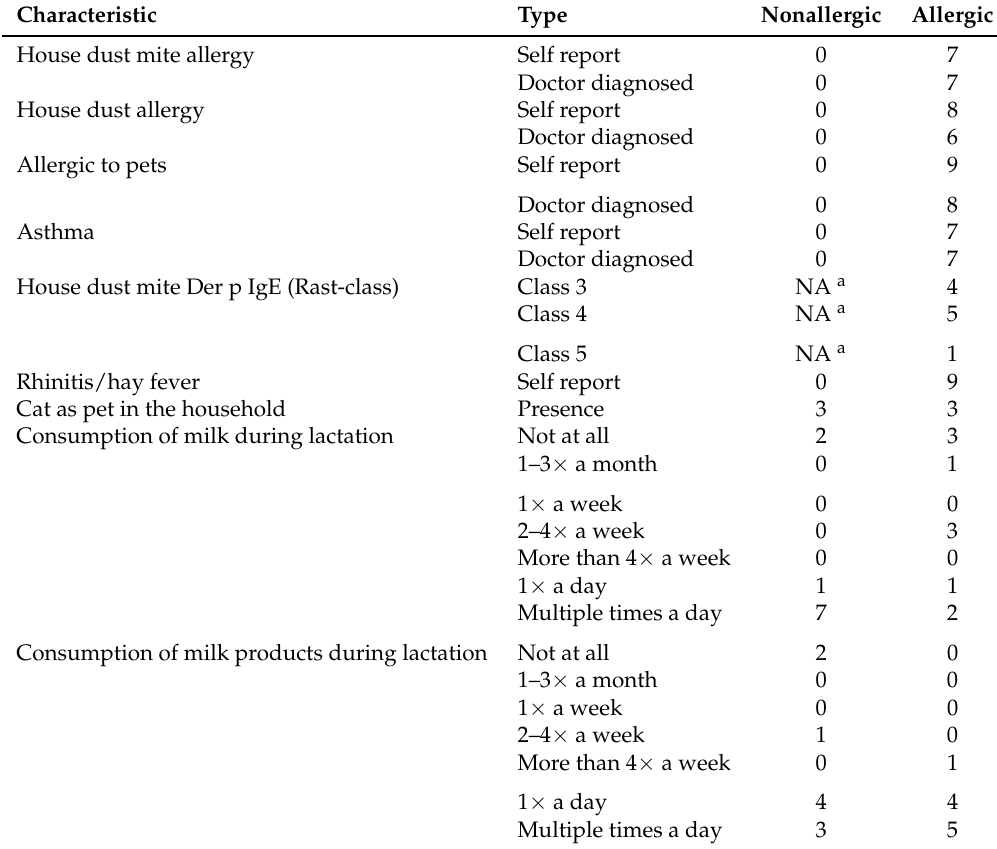
Table 1. Details on the mothers included in the sample collection, with allergy status, Der p IgE Rast-class of the allergic mothers, presence of a cat as pet, and consumption of milk and dairy products. Characteristic